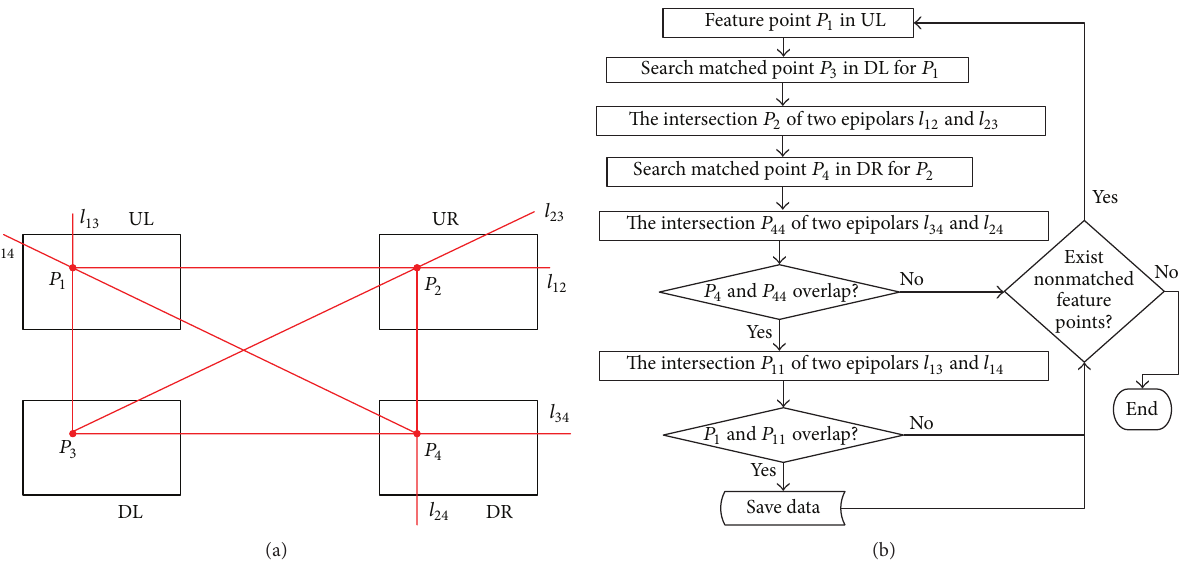
Figure 2: The feature matching method for the PFCPMS: (a) the epipolar characteristic and (b) the flow chart for feature matching.